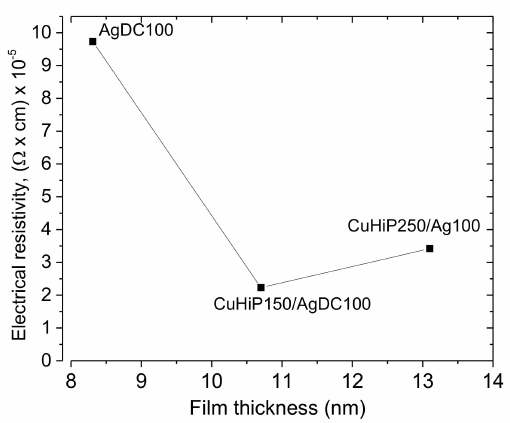
Figure 10. Average resistivity of the Ag100 layer as a function of Cu content.